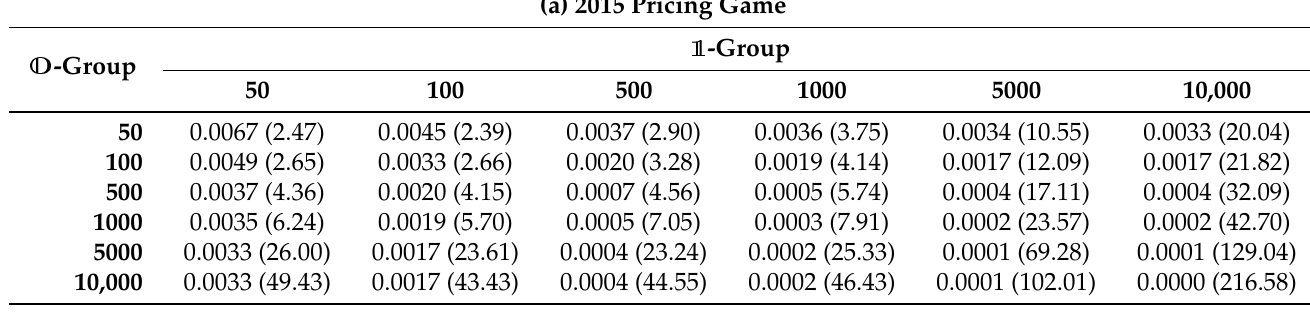
( 0.05 ) on the 0,1 +